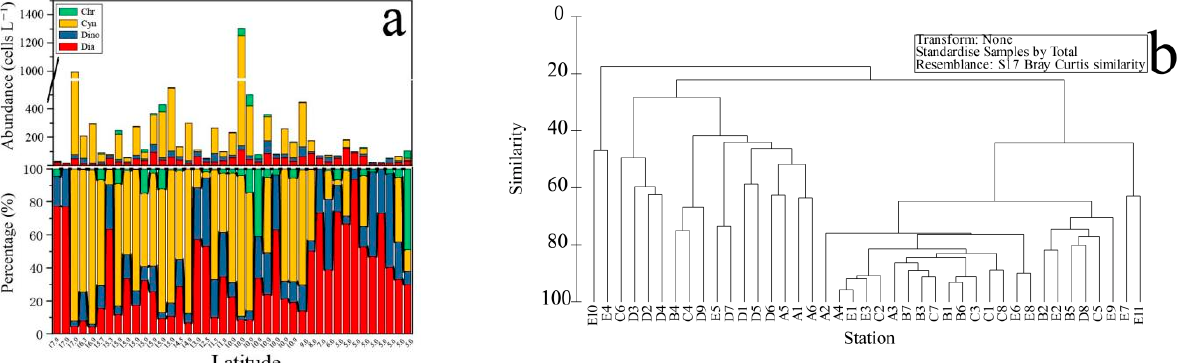
Figure 6. Phytoplankton community structure and cluster analysis in the BOB. ( a ) Average cell abundance (cells L − 1 ) and percentage (%) at every station. ( b ) Bray-Curtis similarity in BOB. (Diatom: Dia; Dinoflagellate: Dino; Cyanobacteria: Cyn; Ochrophyta: Chr).